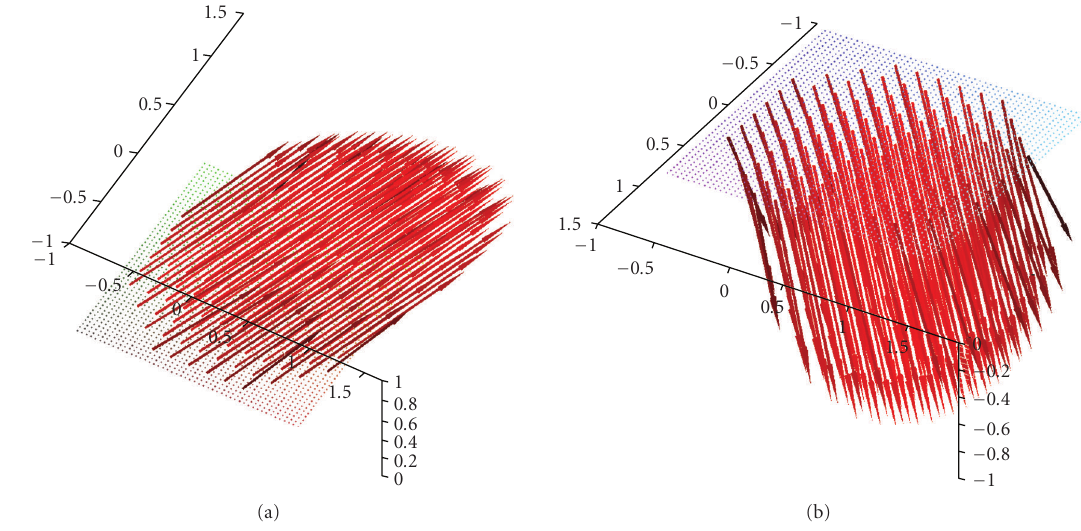
Figure 20: (a) Reconstruction of the vector field f ( x ) = (1,1,1) (cid:9) with the described algorithm for γ = 0 . 007 using three orthogonal circles in the planes { x i = 0 } , i = 1,2,3. (b) Reconstruction of the vector field f ( x ) = (1,1, − 1) (cid:9) with the described algorithm for γ = 0 . 007 using three orthogonal circles in the planes { x i = 0 } , i =